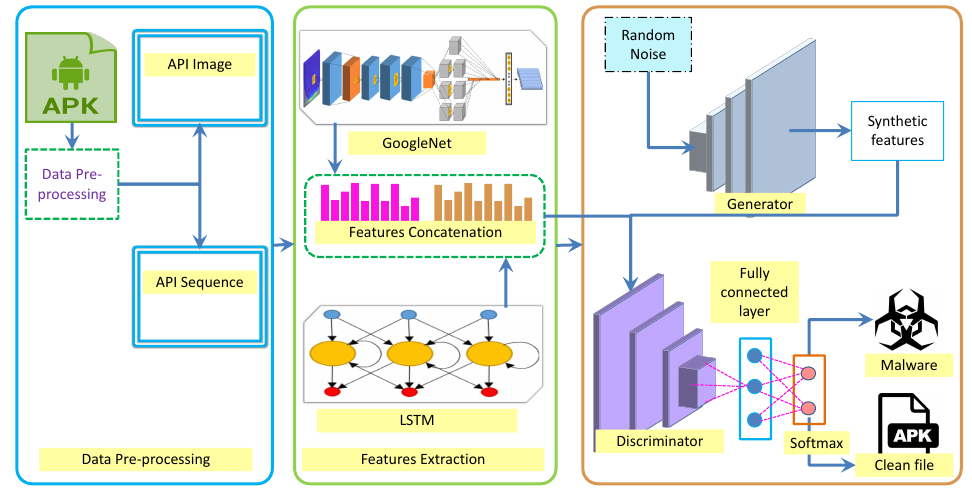
Figure 1. Proposed Framework.